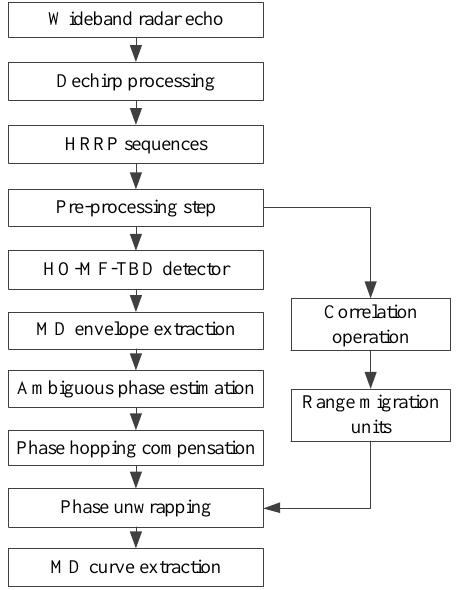
Figure 3. Flowchart for the implementation of the proposed